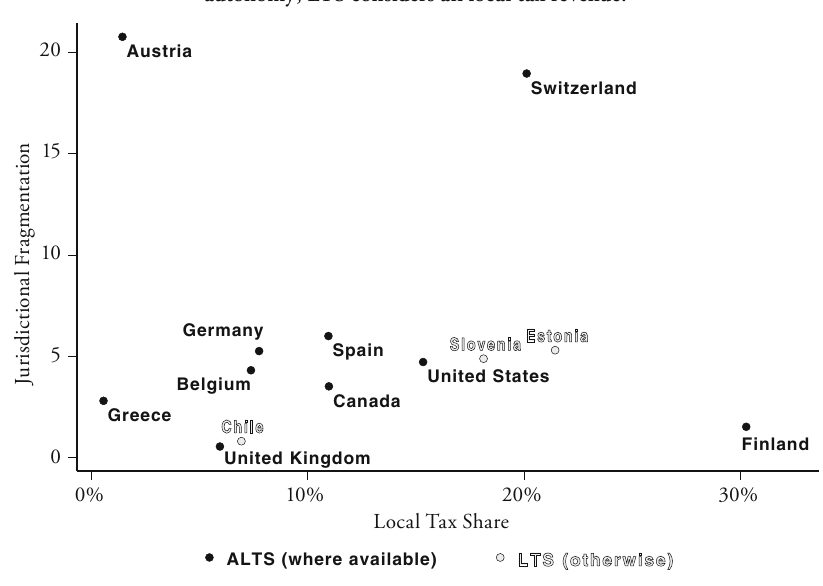
Figure 2: Jurisdictional fragmentation (average number of municipalities per 100,000 inhabitants, 2012) and local tax decentralization (local tax revenue as a share of general government tax revenue, various years). ALTS considers local tax revenue with real tax autonomy; LTS considers all local tax